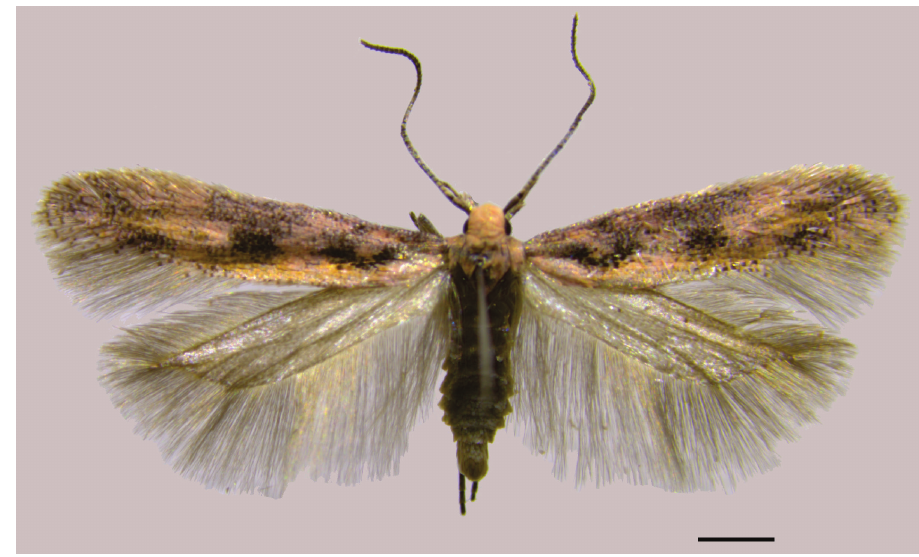
Figure 3. Holotype male of Scrobipalpulopsis aguilaensis sp. nov., dorsal. Scale bar: 1